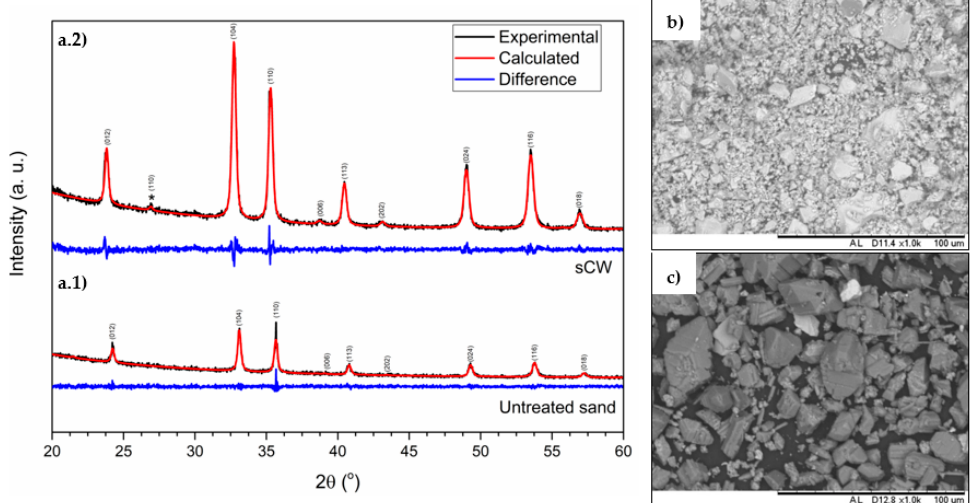
Figure 3. XRPD patterns of the untreated sand precursor ( a.1 ) and the sample treated with sCW at 155 °C and 50 bar ( a.2 ). Unmarked peaks: ilmenite–hematite solid solution, PDF #01-070-8143 [13]. Marked peaks: rutile, PDF #21-1276. Calculated patterns (in red) obtained by Le Bail adjustment. SEM images of ( b ) untreated sand precursor and ( c ) the sample treated with sCW at 155 °C and 50 bar.